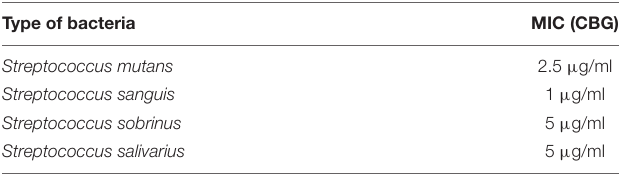
TABLE 1 | The minimal inhibitory concentration (MIC) of CBG toward four different oral bacteria. Type of